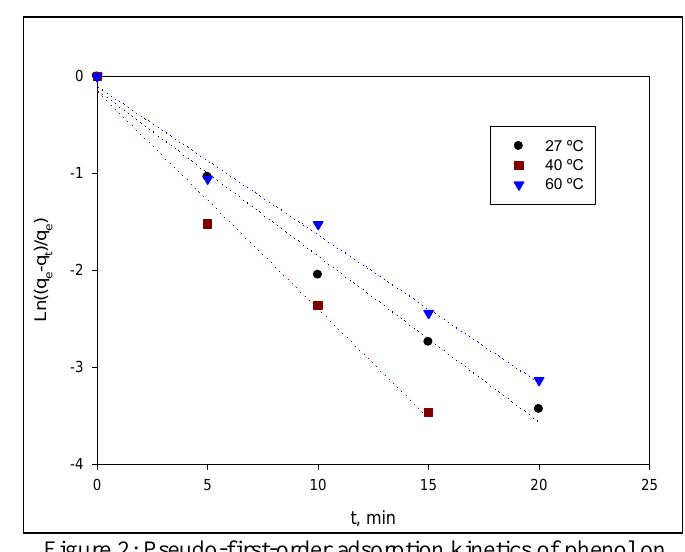
Figure 2: Pseudo-first-order adsorption kinetics of phenol on SBFA.